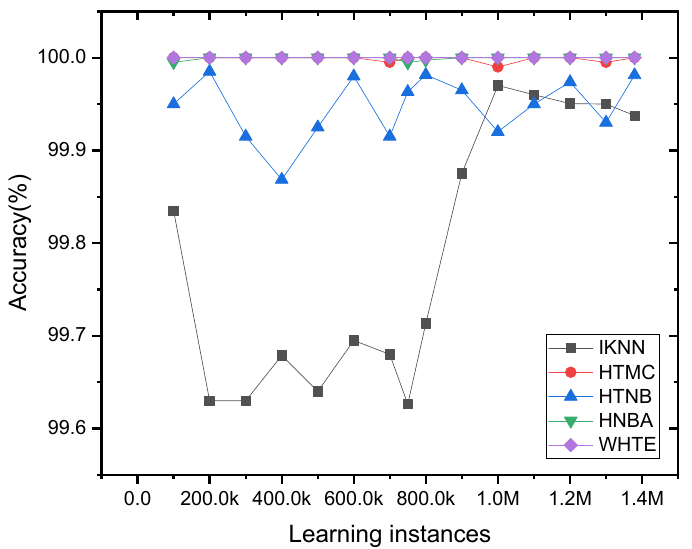
Figure 12. The incremental accuracy of the applied methods, except INB, per 5K sliding window samples for the NetFlow-ToNIoT dataset. For clear visualization, the accuracy was averaged for every 100K samples.